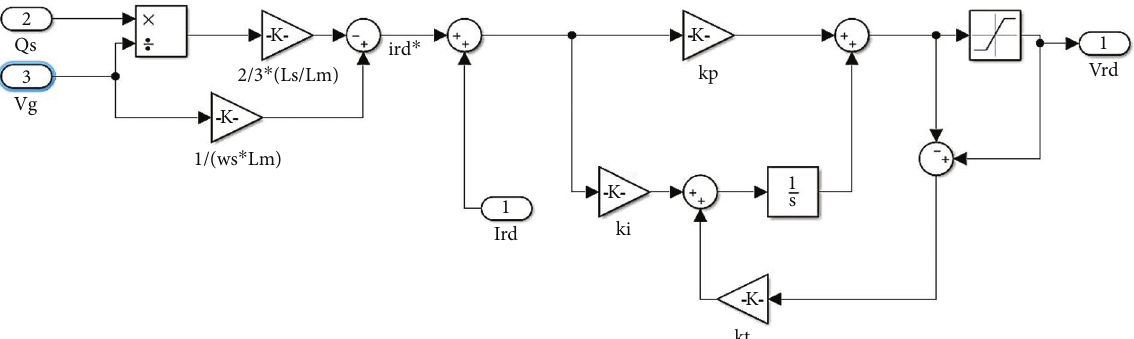
Figure 3: PI controller for the stator reactive power in MATLAB Simulink.